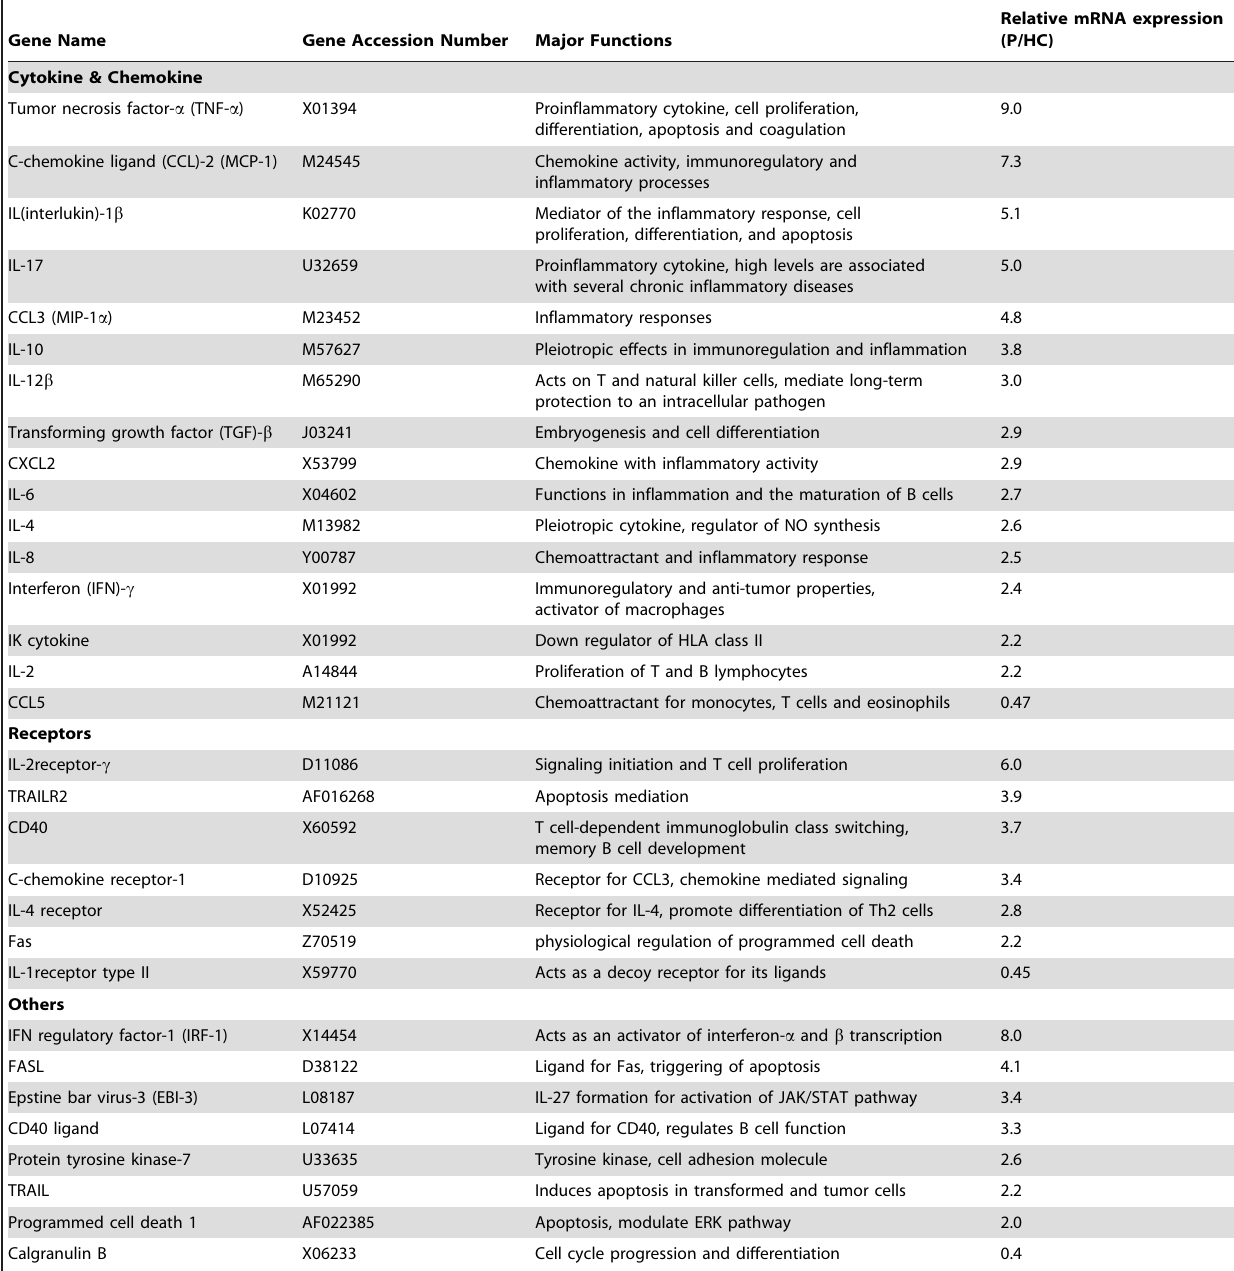
Table 2. Genes showing altered expression in tissue lesions of PKDL (P) compared to human normal skin (HC).